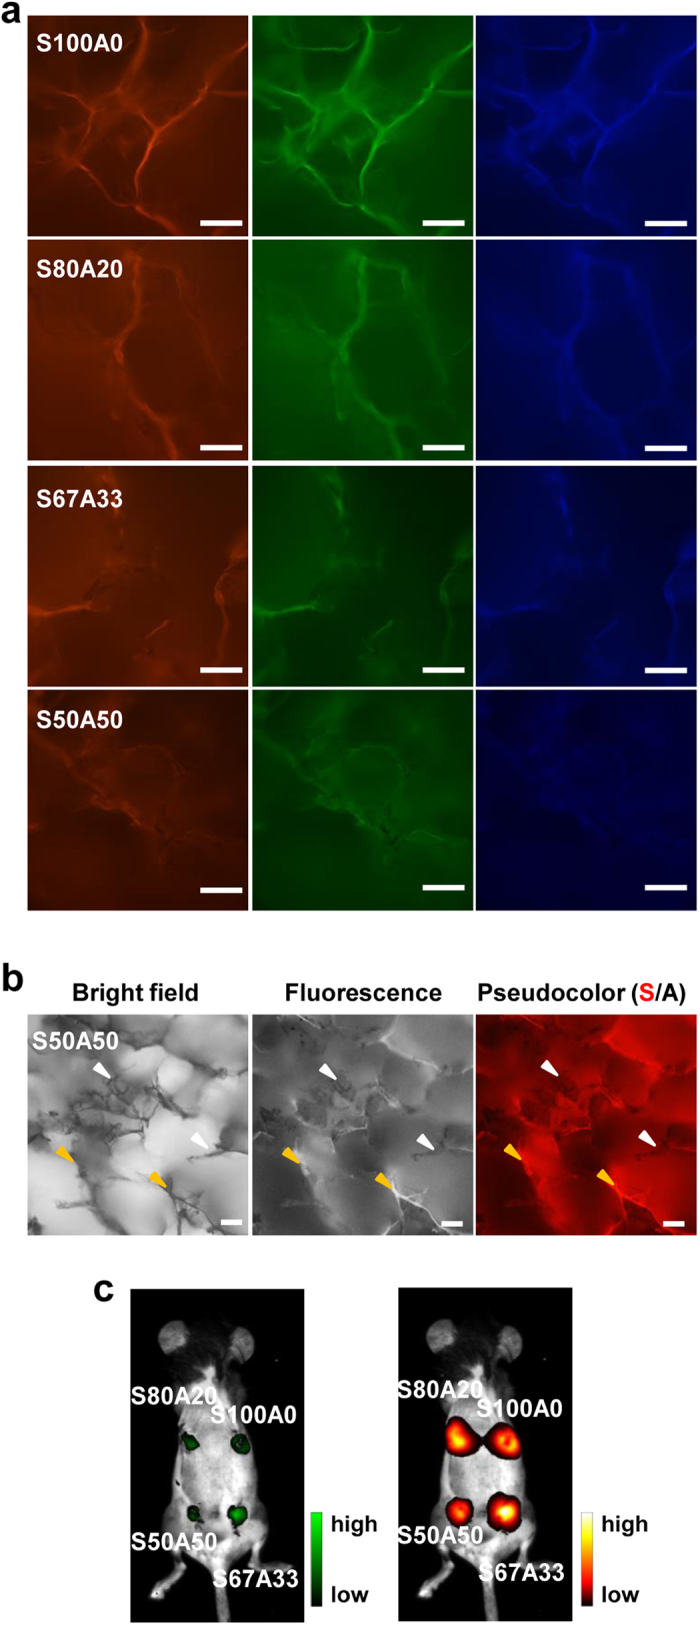
The photoluminescent property of the sericin-alginate IPN hydrogels.(a) 3D micro-structures of the IPNs were observed using confocal laser scanning microscopy under the light at the different wavelengths (left, imaged with the excitation wavelength 530-550 nm with the filter allowing the passage of the emission wavelength 575–625 nm; middle, imaged with 460–495 nm and with the filter allowing the passage of the emission wavelength 510 nm; right, imaged with the excitation wavelength 360–370 nm and with the filter allowing the passage of the emission wavelength >420 nm). Scale bars, 100 μm. (b) The double interpenetration networks within the IPN hydrogel (S50A50) were black when observed under the bright field (left). The fluorescent (middle) and corresponding pseudocolored (right) images of this IPN hydrogel show the fluorescent ridges (yellow arrowheads) of the sericin network and the black, non-fluorescent structure of the alginate network (white arrowheads). Scale bars, 100 μm. (c) The mice with the sericin-alginate IPN hydrogels embedded subcutaneously to the dorsal were imaged under the light of 470 nm with the filter allowing the passage of the emission wavelength 535 nm (left) and the light of 630 nm with the filter allowing the passage of the emission wavelength 700 nm (right).